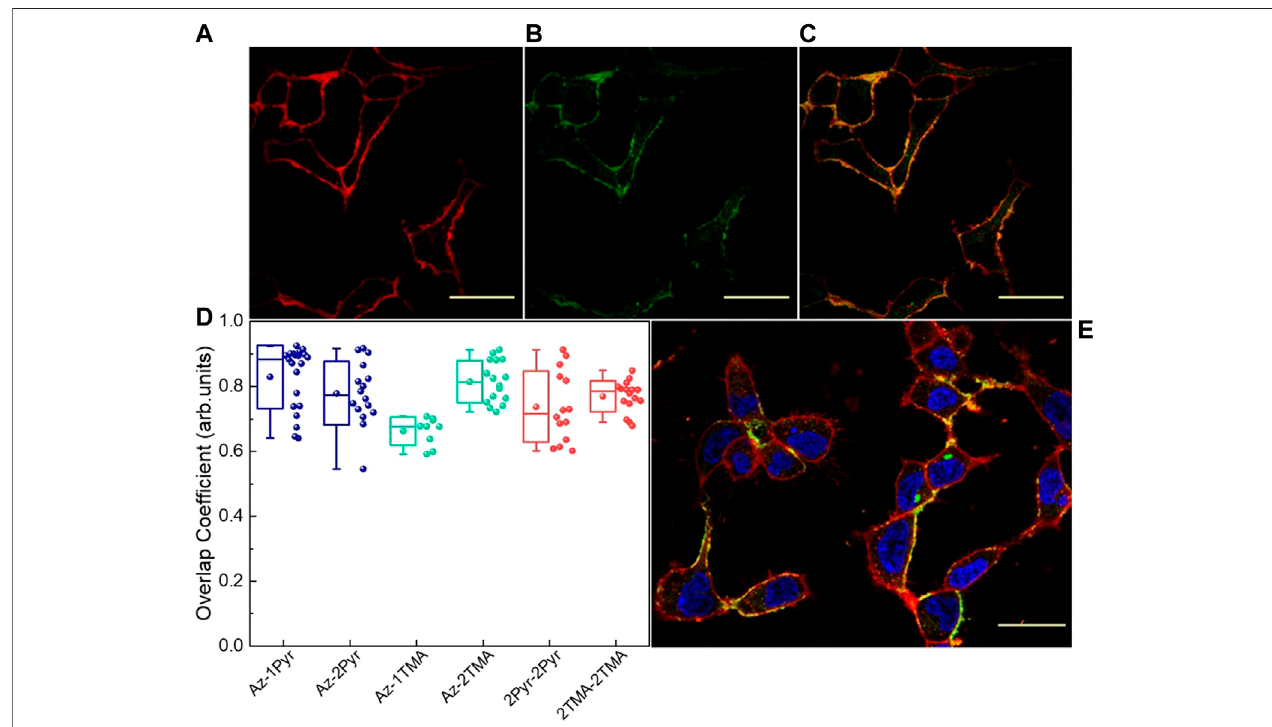
FIGURE2| FluorescenceconfocalimagesshowingtheCellMasklabeledHEK-293cellmembranes (A) ,Az-2Pyrmolecule(25 μ M) (B) ,andtheircolocalization (C) , 7 min after incubation and rinsing. (D) Colocalization analysis overlap coef fi cient (OC) values for the six molecules ( n ≥ 10). (E) HEK-293 cells treated with Az-2Pyr and stained with CellMask (red) and DAPI (blue). Scale bar (cid:1) 50